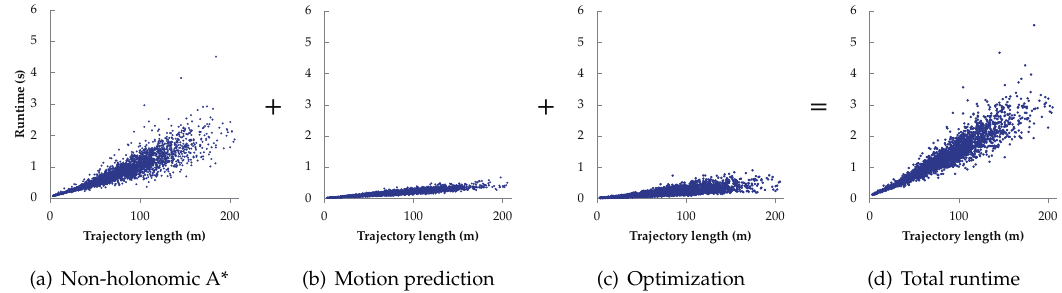
Figure 20. The statistic evaluation of the computational